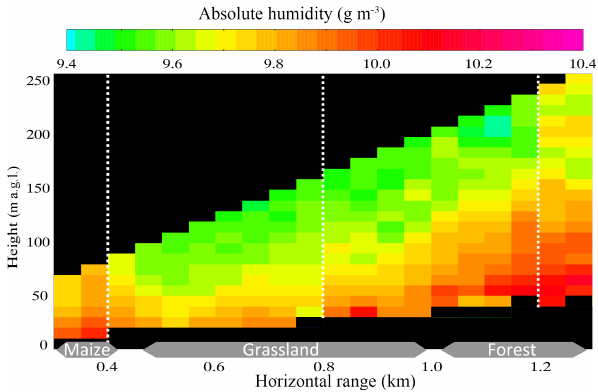
Figure 12. One-hour mean WV field between 11:00 and 12:00 UTC on IOP 4 on 12 August 2014. The covered angle range was 0 to 12 ◦ ; the scan speed was 0.2 ◦ s − 1 ; a single scan took 1min. For the water vapor calculation, 1s averaged data were used. The land cover along the line of sight is also shown. The dotted lines indicate the location of the vertical profiles shown in Fig.